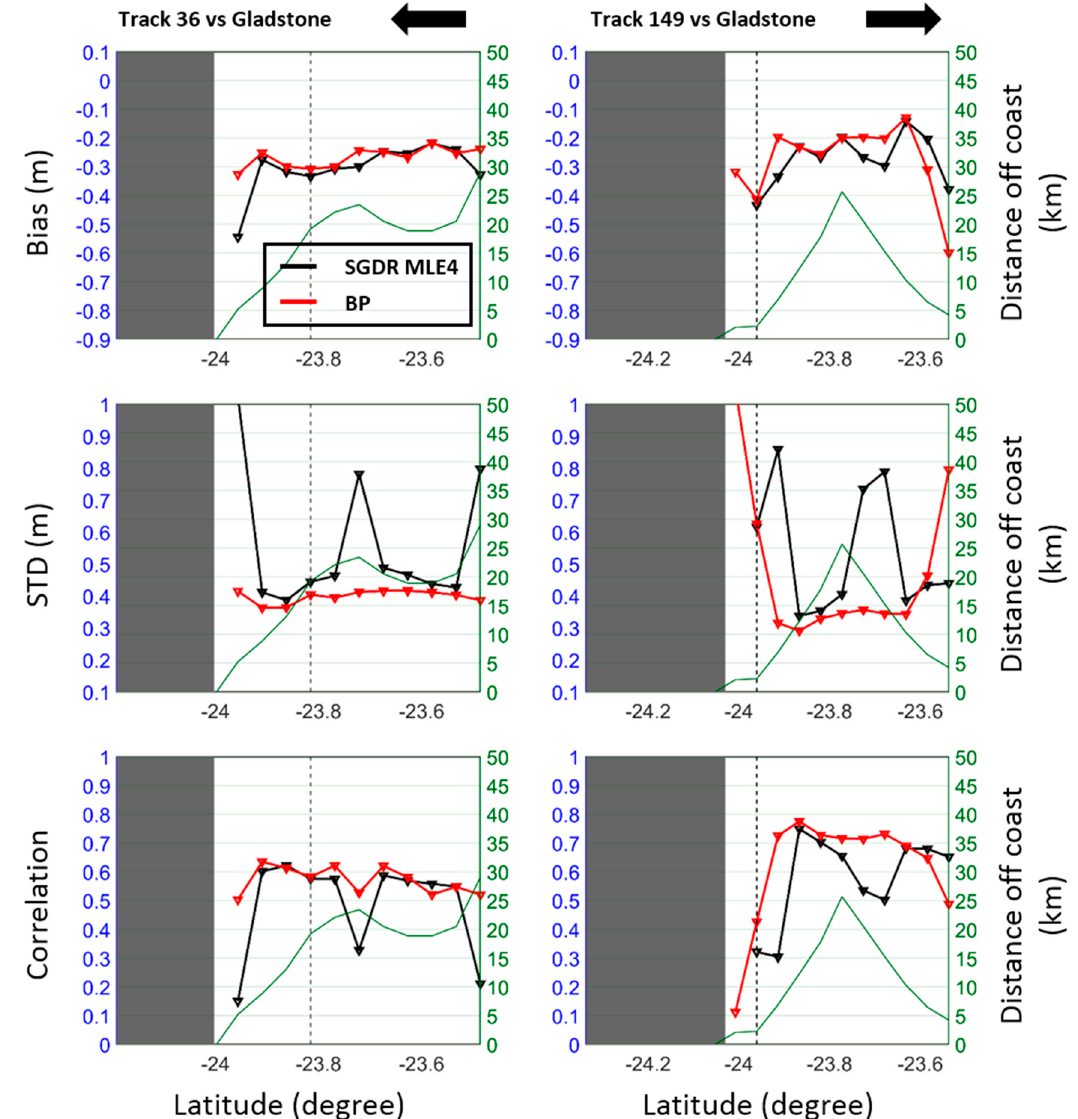
Figure 6. Similar to Figure 5, but for tracks 36 ( left ) and 149 ( right ) against buoy SWHs at Gladstone in Central Queensland.